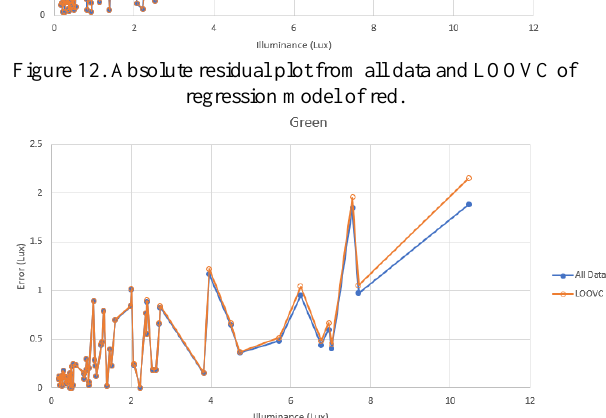
Figure 13. Absolute residual plot from all data and LOOVC of regression model of green